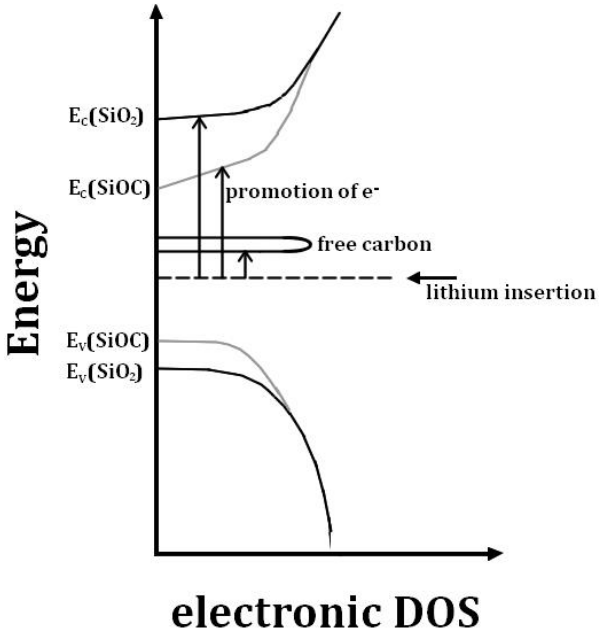
Figure 3. Schematic scheme of the electronic density of states for a-SiO2, SiOC and free carbon according to Reference